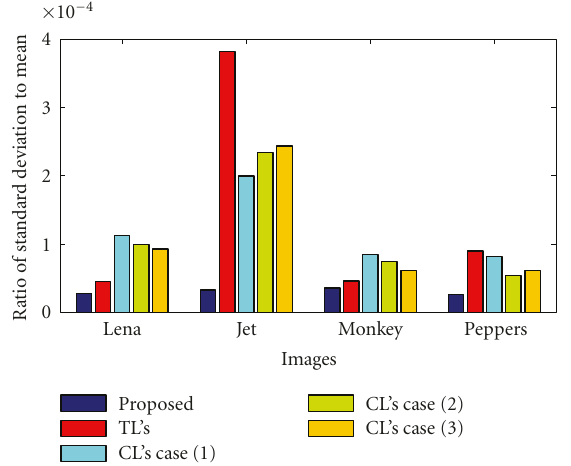
Figure 10: Average value of the ratio of standard deviation to mean of histograms of six shadow images for test images Lena, Jet, Mon- key and Peppers.